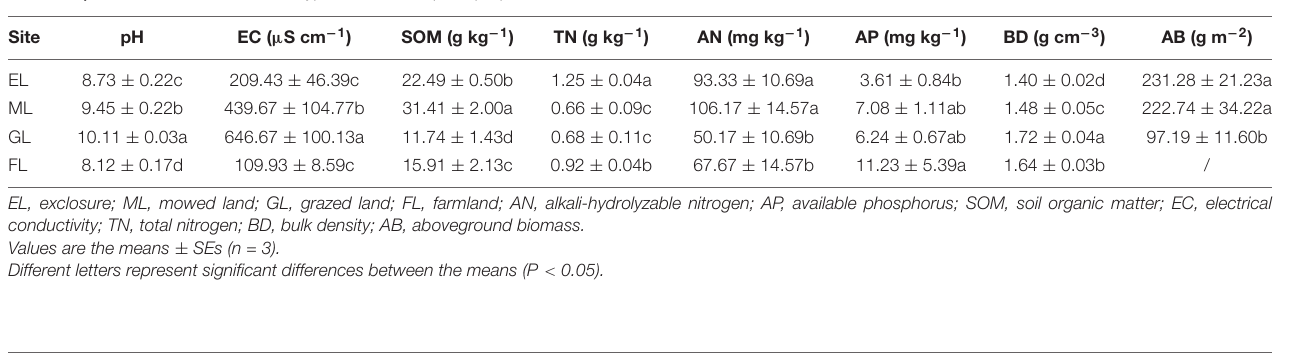
TABLE 2 | Effects of different land use types on soil and plant